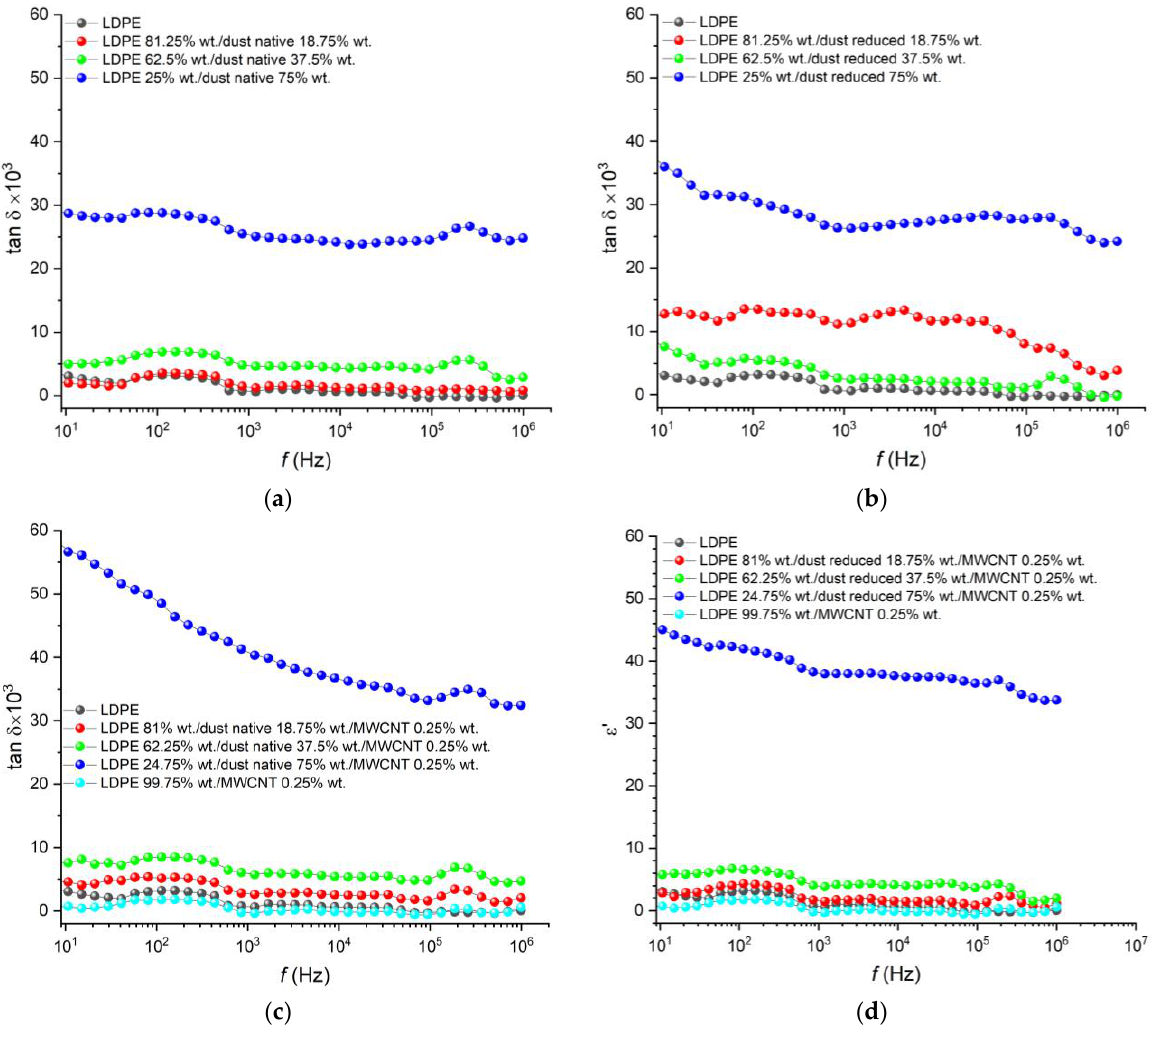
Figure 5. The frequency dependence of dielectric loss tangent of composite films based on LDPE filled with ( a ) native dust, ( b ) reduced dust, ( c ) native dust /MWCNT, and ( d ) reduced dust /MWCNT. The frequency dependences of the conductivity of composite films based on LDPE, dust (native and reduced), and MWCNT are shown in Figure